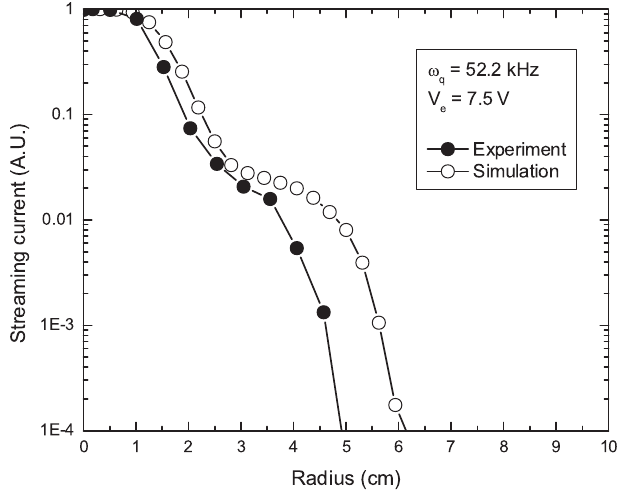
FIG. 4. 3D WARP PIC simulation of injection mismatch with (cid:2) 52 : 2 kH z and V (cid:2) 7 : 5 V , showing both rapid and slow ! q e oscillations near z (cid:2) 0 m. For larger z , the envelope oscillations result in a diffuse halo around the